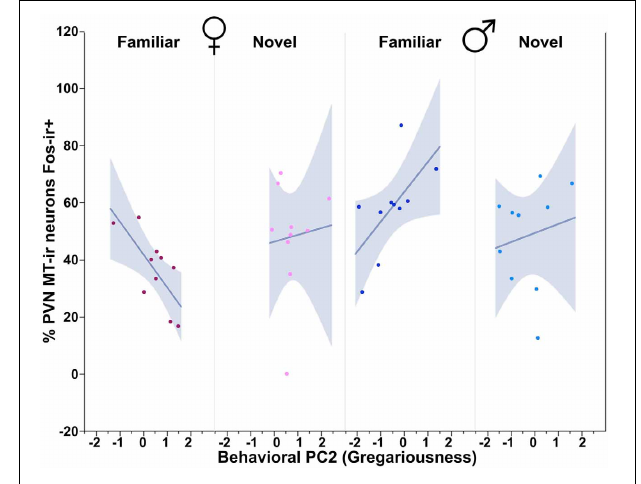
FIGURE 6 | Numbers of VT-Fos double-labeled neurons in the PVN as a function of an interaction between Behavioral PC3 (Anxiety), Sex and Context. Anxiety tends to correlate positively with the number of PVN VT neurons expressing Fos in females and in males exposed to familiar same-sex conspecifics, but negatively in males exposed to novel conspecifics. Sex × Context × Behavioral PC3 F ( 1 , 32 ) = 4 . 12, p = 0 . 05. The 95% confidence interval is indicated by shading.